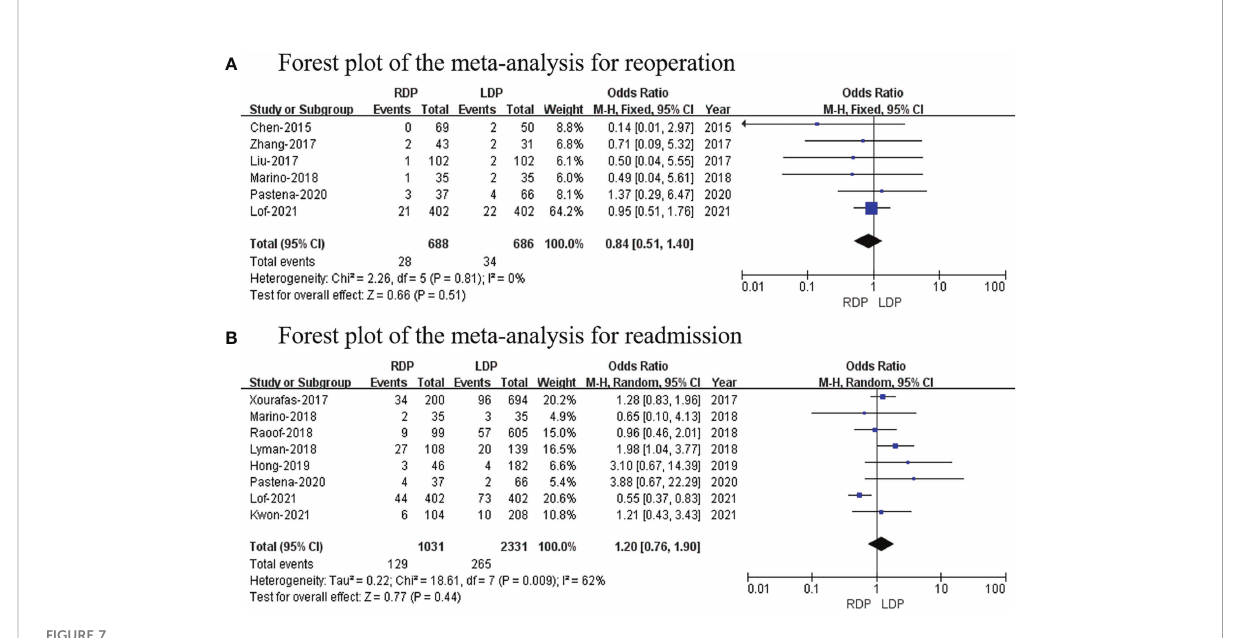
FIGURE 7 Forest plot of the meta-analysis for (A) reoperation and (B)